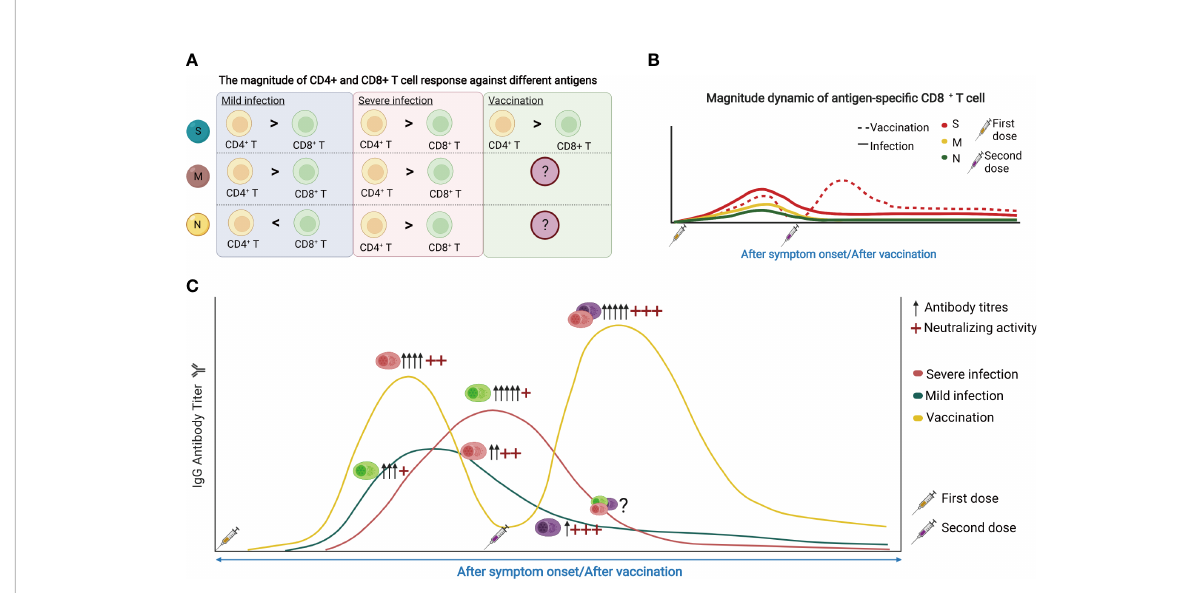
FIGURE 4 (A) The magnitude of CD4 + and CD8 + T cell response against different antigens. S, spike protein; M, membrane; N, nucleocapsid. (B) The dynamic of SARS-CoV-2 reactive CD8 + T cell response following SARS-CoV-2 infection and vaccination. (C) The dynamic of SARS-CoV-2 reactive antibodies and memory B cells in response to SARS-CoV-2 infection and vaccine. The fi gure was created using